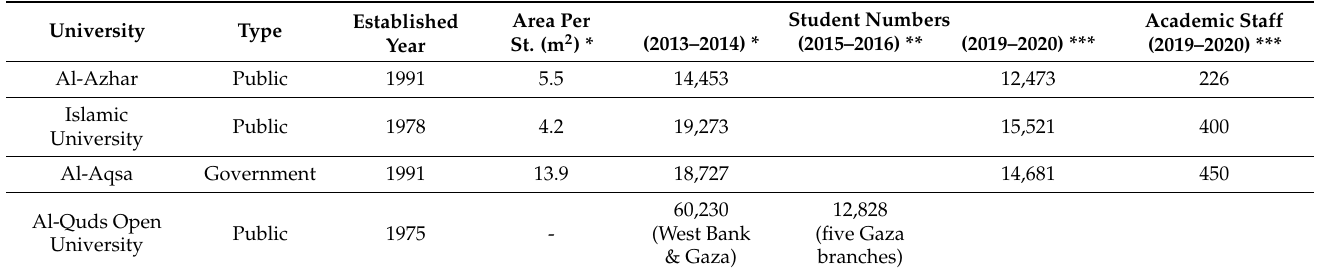
Table 2. Overview universities included in the study.